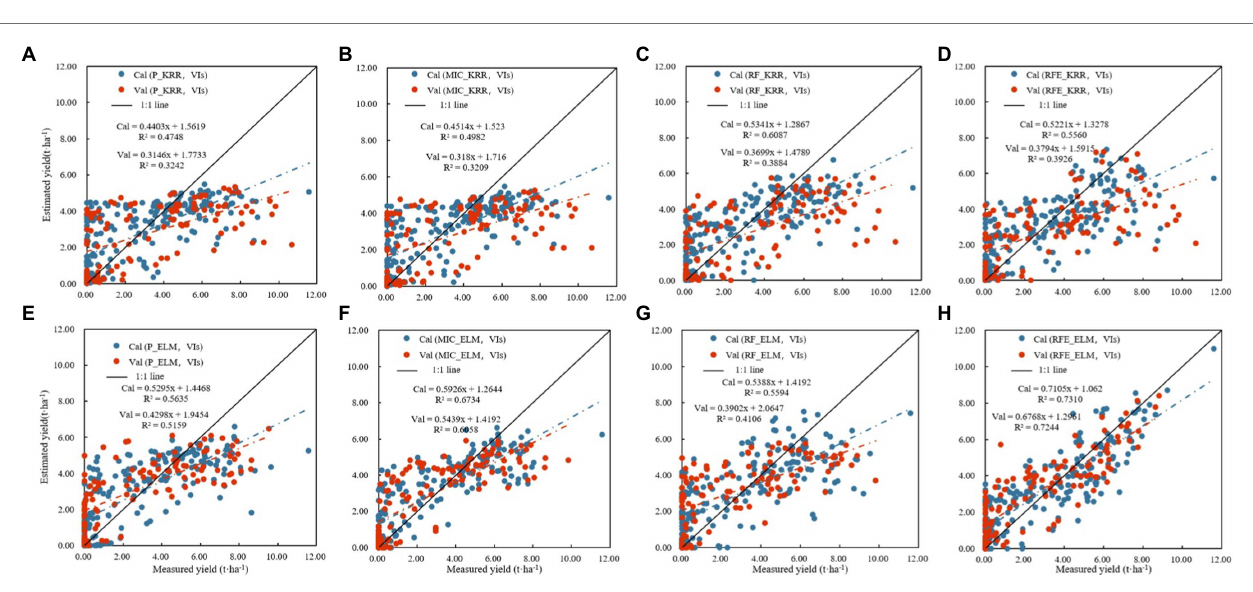
FIGURE 7 | Cotton yield estimation models established by best performing based on the visible vegetation indices by using the linear and nonlinear models (Note: (A) P_KRR model; (B) MIC_KRR model; (C) RF_KRR model; (D) RFE_KRR model; (E) P_ELM model; (F) MIC_ELM model; (G) MIC_ELM model; (H) RFE_ELM